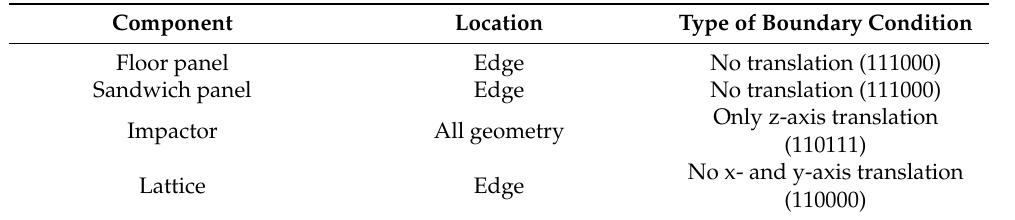
Table 1. Boundary conditions.